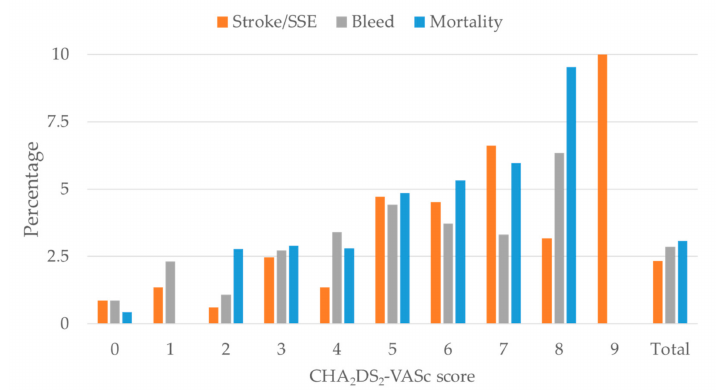
Figure 1. Outcomes (stroke / systemic embolic events (SSE), bleeding and mortality) by CHA 2 DS 2 -VASc risk score in the present study.